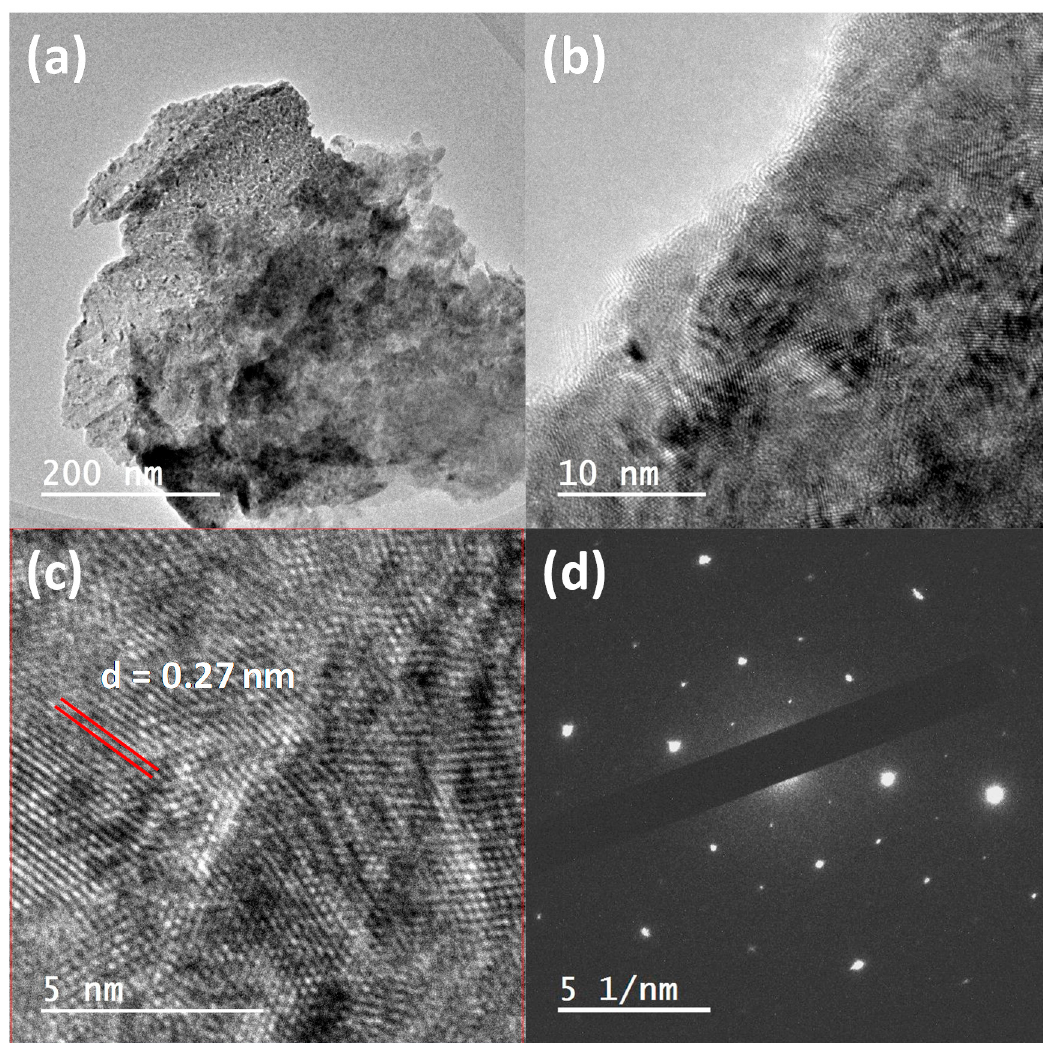
Figure 2. ( a – c ) HR-TEM images of Fe–Pd continuous thin film with a 20 nm layer thickness taken at different magnifications. Regions with different directions of the crystallographic planes are shown in ( b , c ). ( d ) The SAED image along a direction near a two-fold symmetry axis (see text).